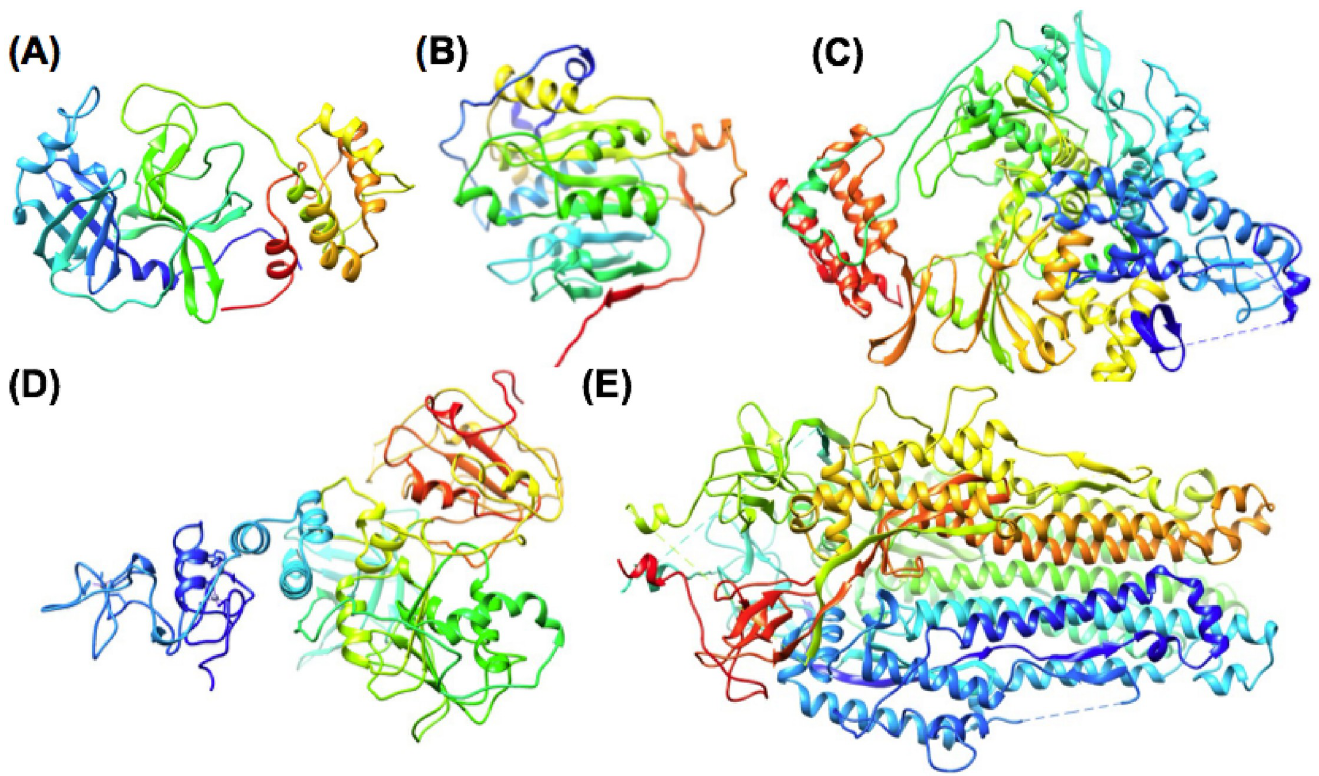
Fig 1. Major SARS-CoV-2 drug target proteins analyzed using pharmacophore mapping and computational fragment screening. (A) Nsp5 Mprot (B) Nsp16 2’-O MT, (C) Nsp12 RdRp (D) Nsp13 Helicase (E) S2 Spike. Protein structures are shown using ribbon diagram with RGB (red-green-blue) rainbow coloring from the N- terminus (blue) to the C-terminus